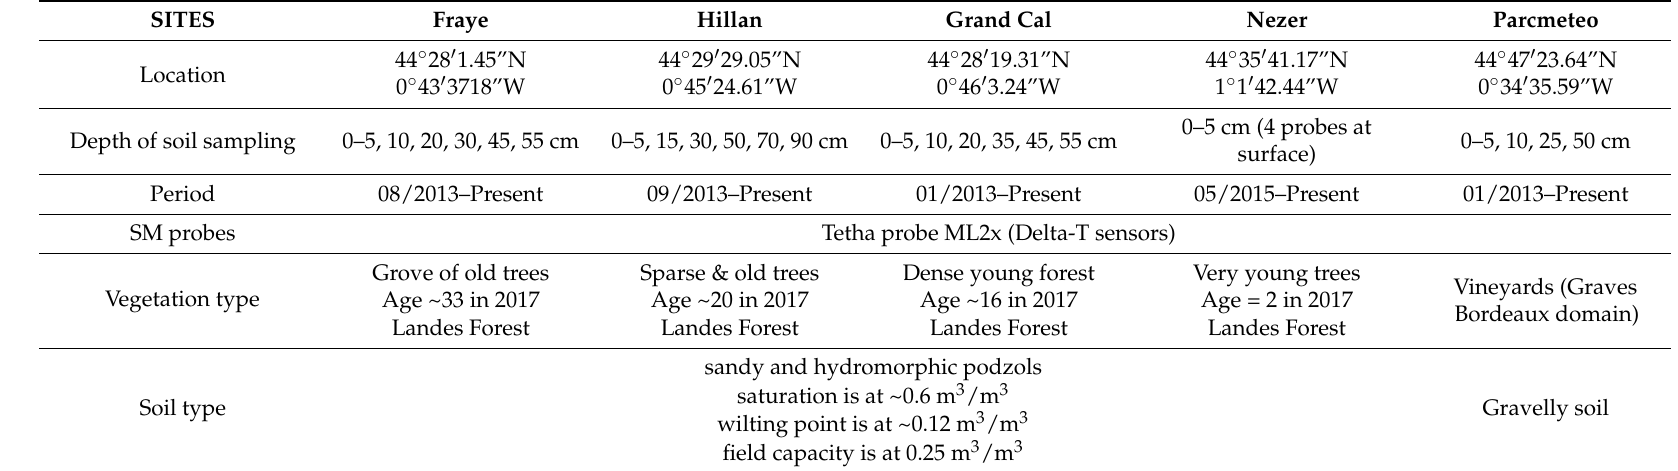
Table 1. The main characteristics of the Bouron, Nezer, and Parcmeteo sites